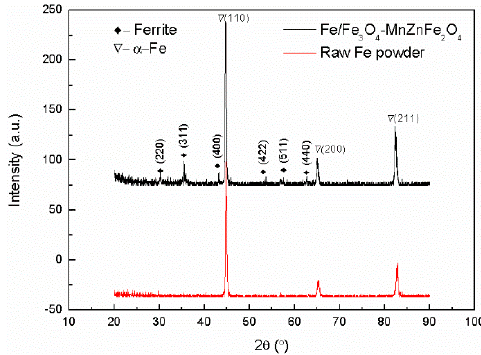
Figure 4. XRD pattern of raw iron powders and Fe 3 O 4 –MnZnFe 2 O 4 coated iron powders.